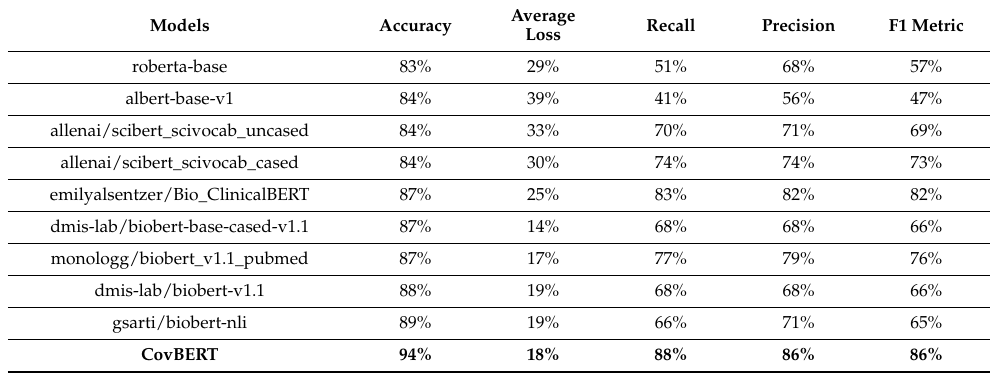
Table 5. Comparative study of BERT, its variants and our proposed CovBERT model. Models Accuracy Average Loss Recall Precision F1